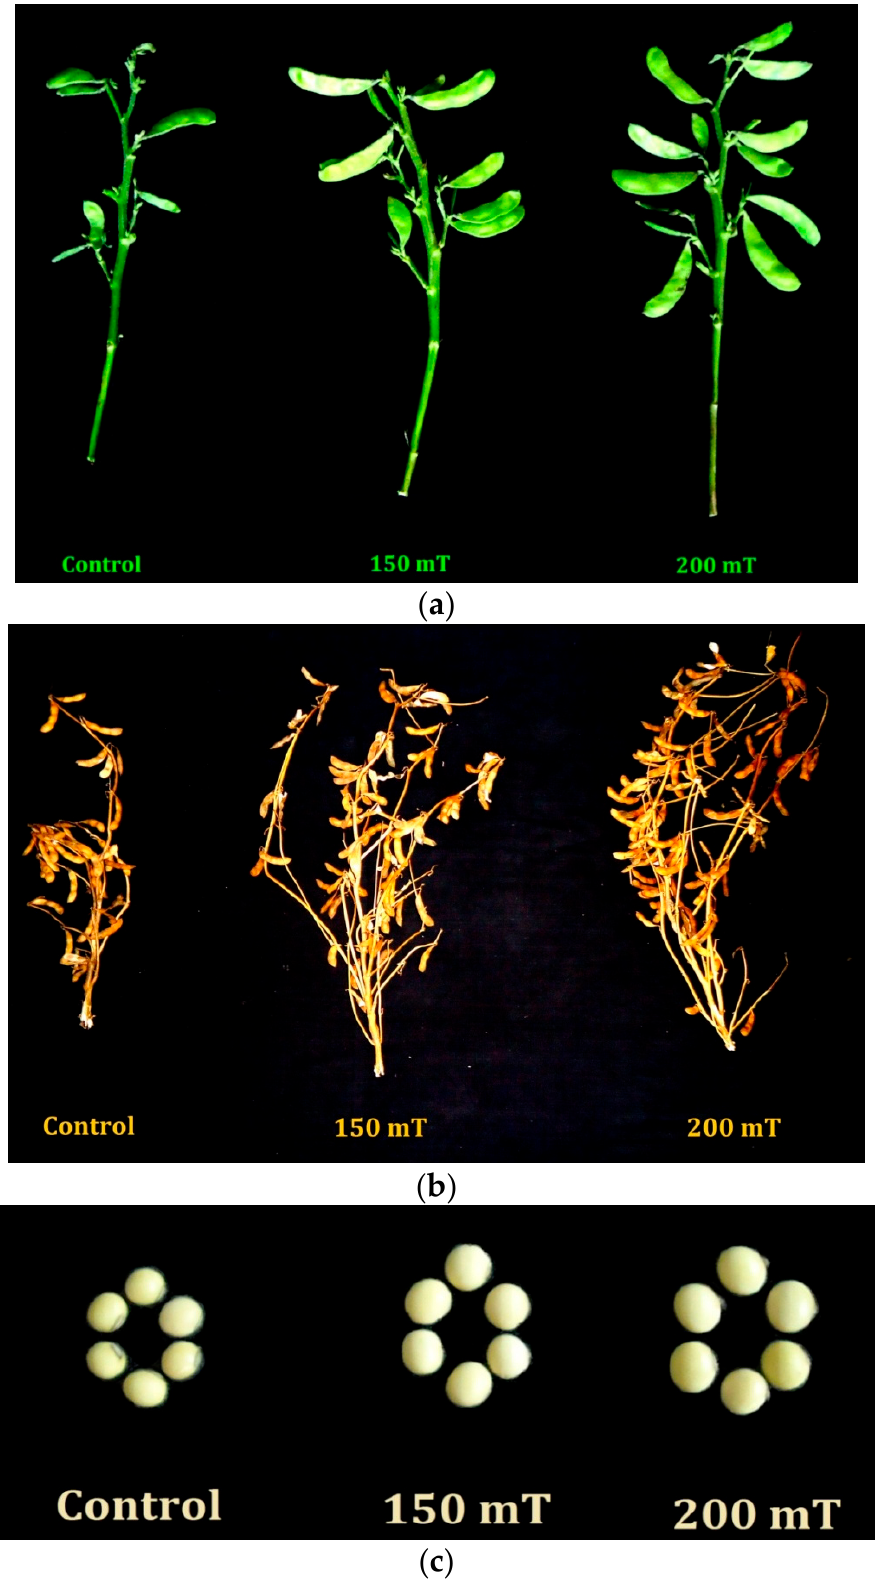
Figure 19. Photograph showing effect of pre-sowing exposure of soybean seeds to magnetic field on yield attributes: pods at 55 DAE ( a ), pods ( b ), and seed size ( c ) at harvest maturity (120 DAE).